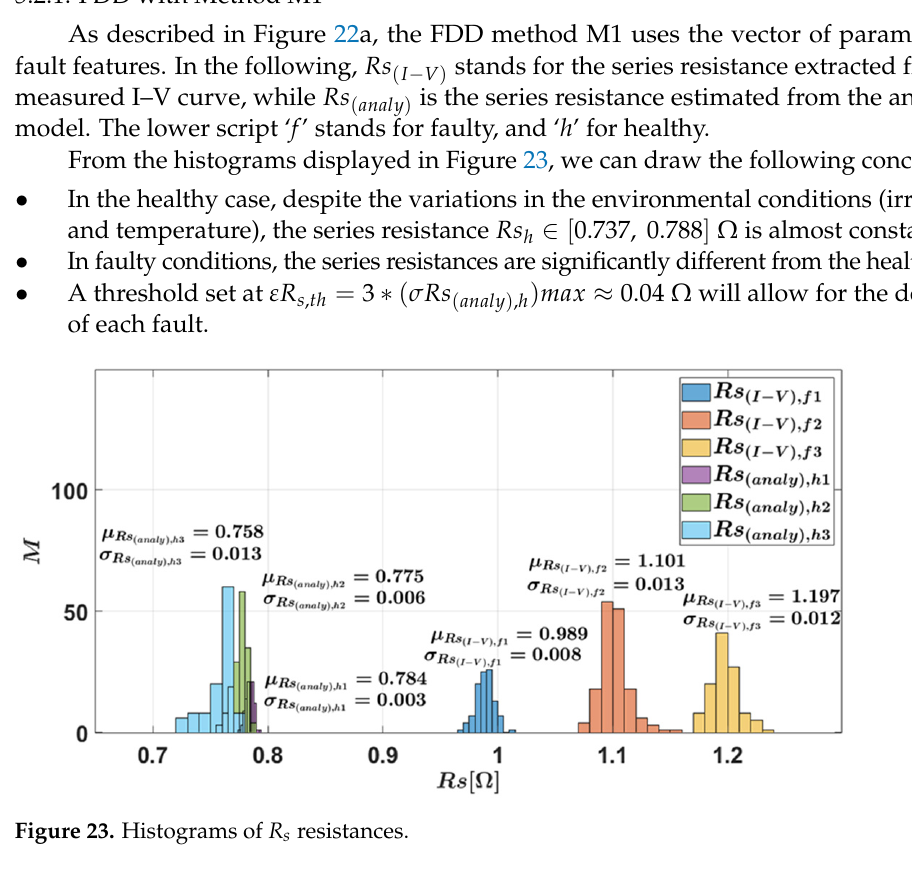
Table 14. Data acquisition in case of R s degradation.